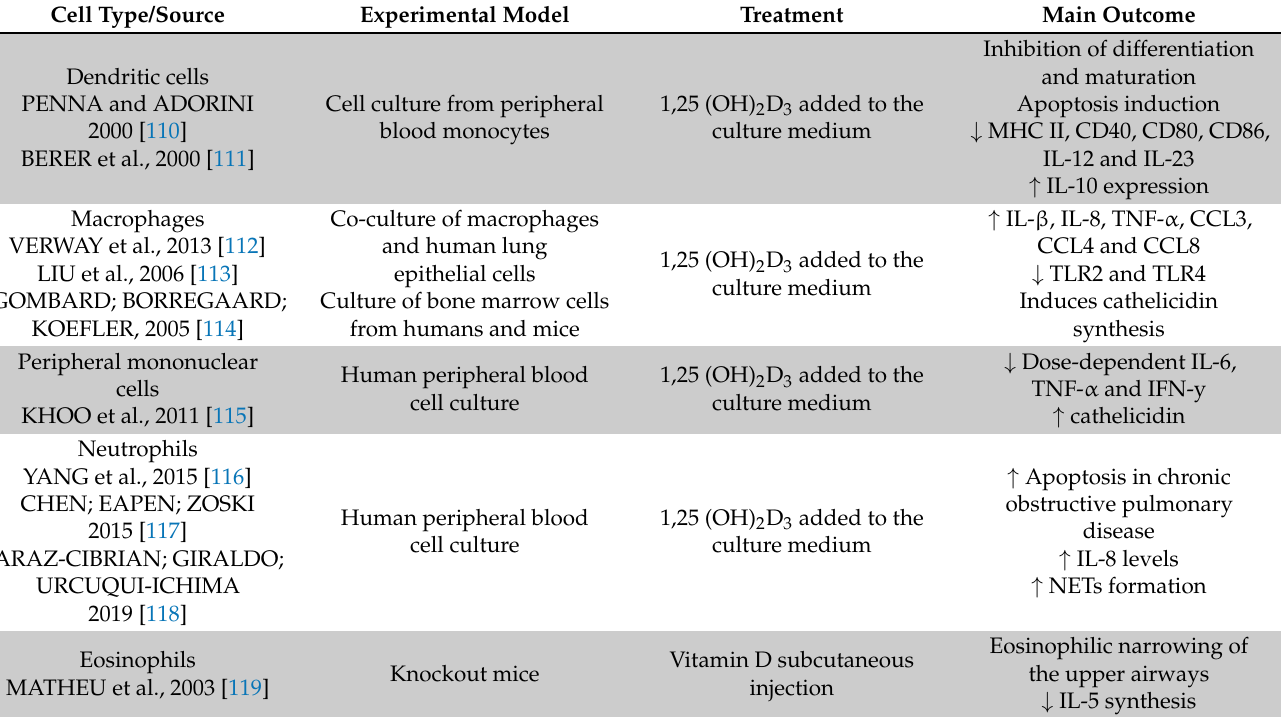
Table 1. Impact of vitamin D on immune response cells. The arrows ↓ and ↑ indicate reduction or increase in expression,